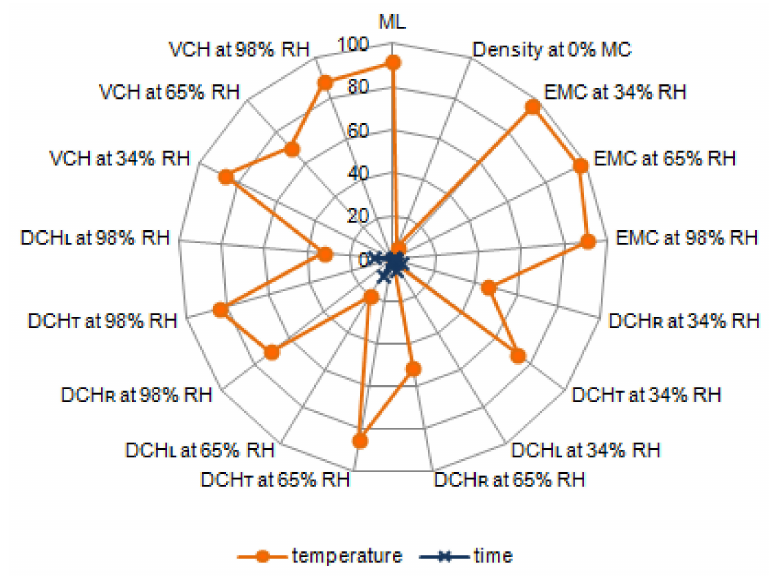
Figure 2. The percentual influence of temperature and modification time on the mass loss (ML), den- sity ( ρ ), equilibrium moisture content (EMC), dimensional changes in the radial (DCH R ), tangential (DCH T ), longitudinal (DCH L ) directions and volumetric changes (VCH) of black poplar thermally modified in nitrogen atmosphere.